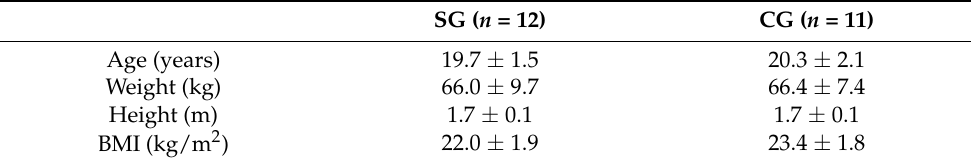
Table 1. Participants’